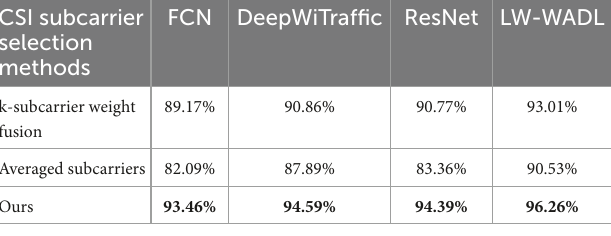
TABLE 2 Accuracy of different subcarrier selection methods. CSI subcarrier selection methods